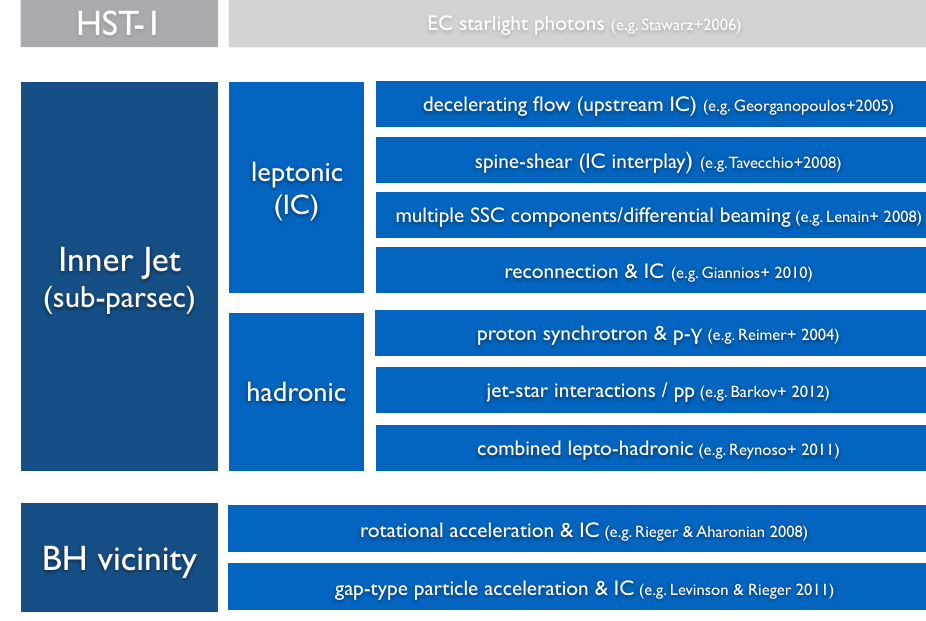
Figure 6. Possible scenarios for the origin of the variable VHE emission in M87 with exemplary references. Day-scale variability favours models on scales of the inner jet and below. “IC” refers to inverse Compton